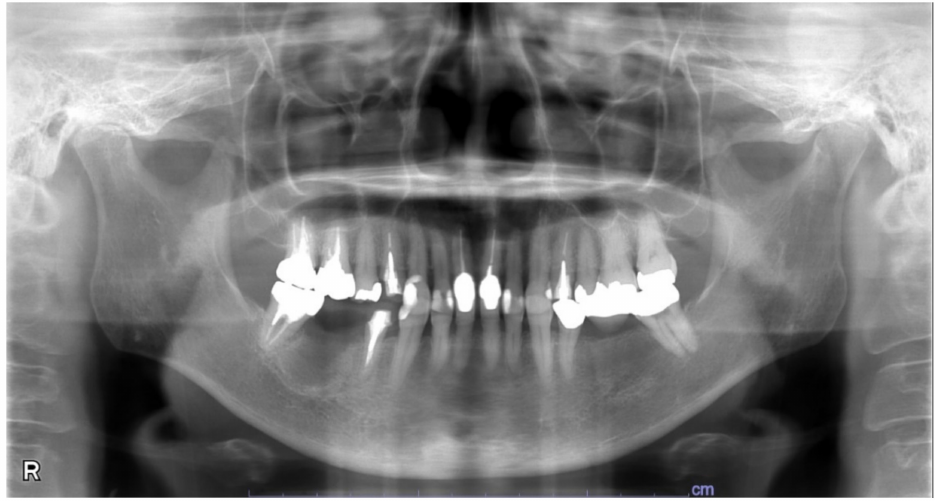
Figure 7. A panoramic radiography image taken during the one-month follow-up period after